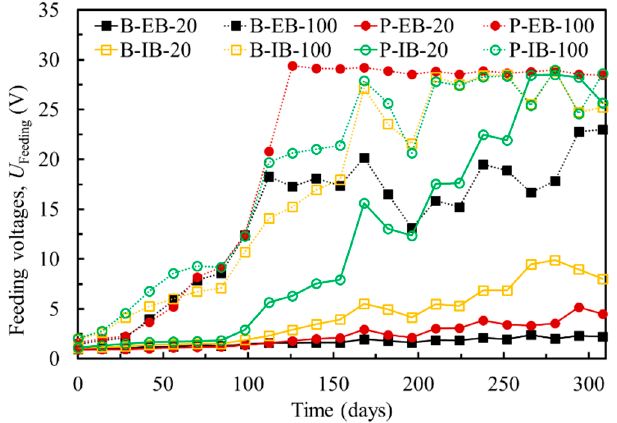
Figure 7. Driving voltages between the steel and CFRP.